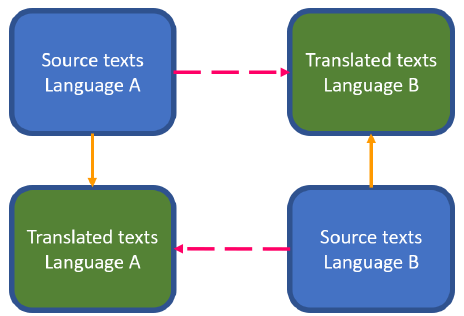
Figure 1. The Contrastive parallel corpus architecture (illustrated for two languages).